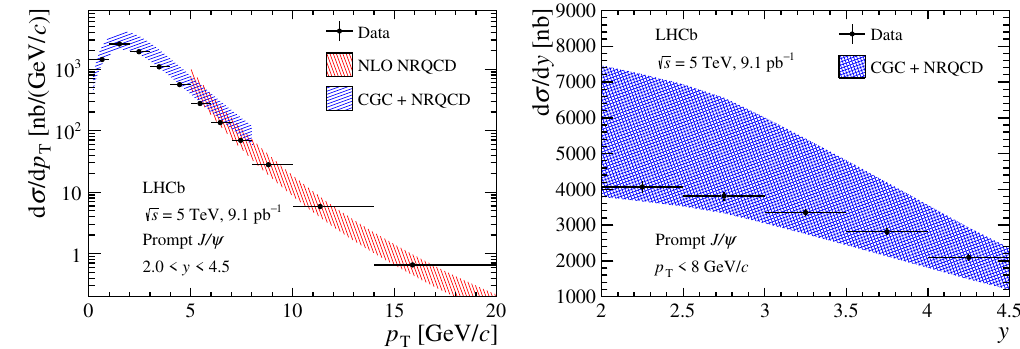
Figure 3 . Differential cross-sections (left) d σ/ d p T and (right) d σ/ d y for prompt J/ψ mesons compared with NRQCD and CGC calculations [54, 55]. Uncertainties due to LDMEs determination, renormalisation scales, and factorisation scales are included in the NRQCD and CGC predictions.